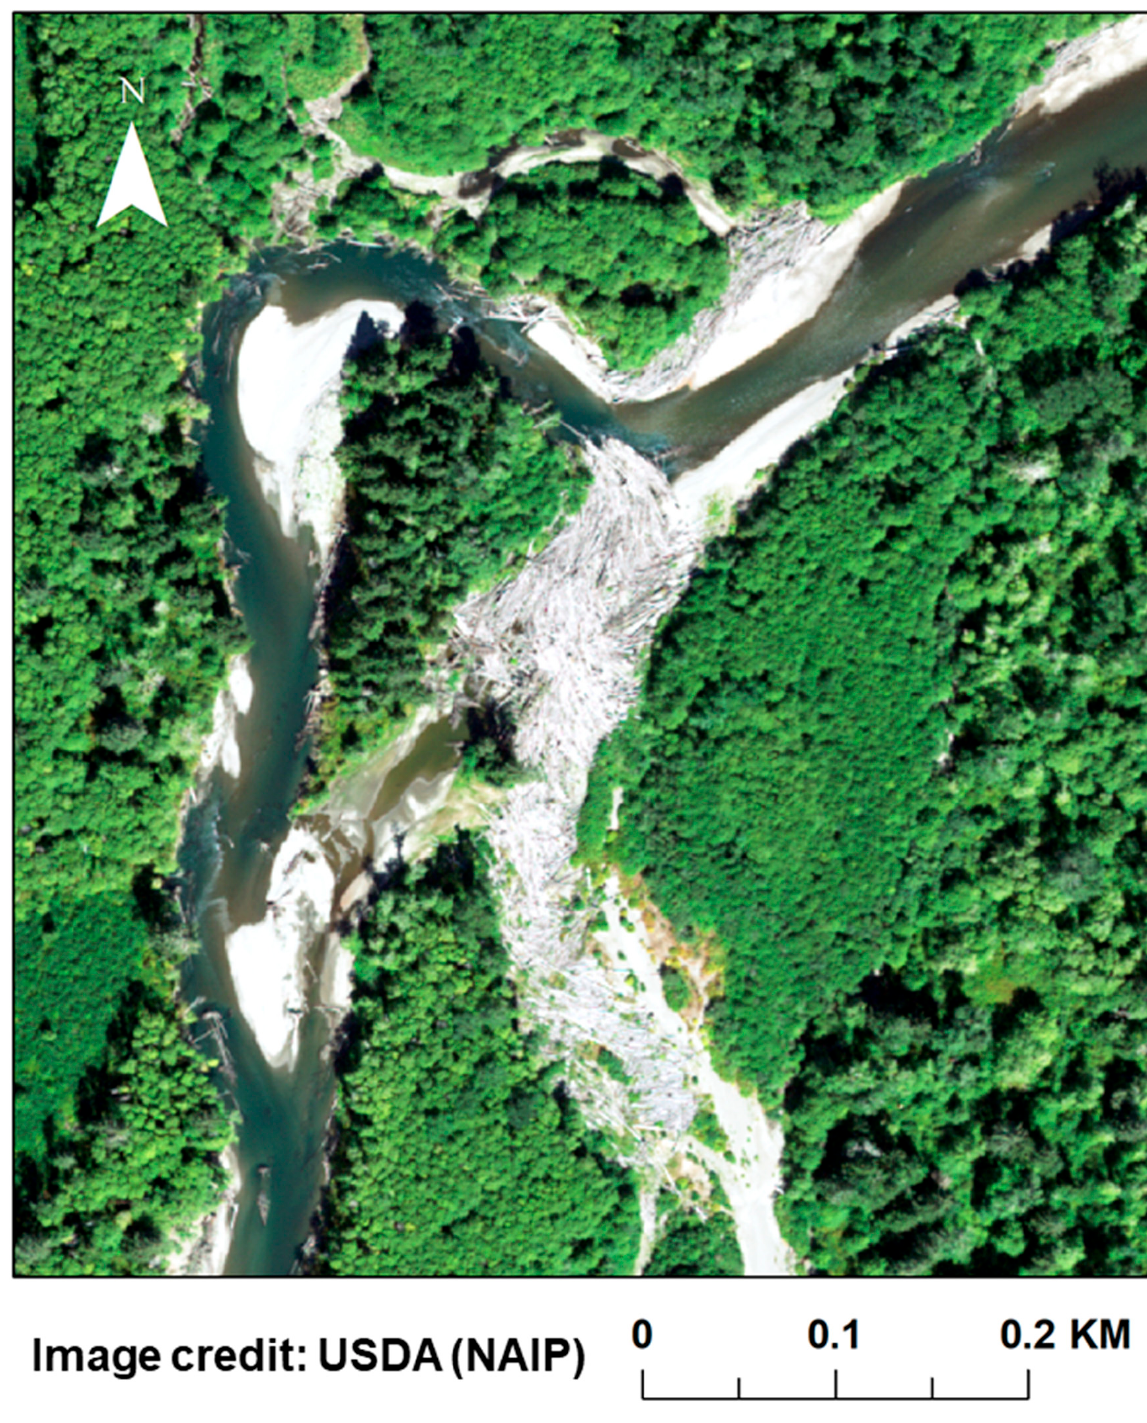
Figure 5. Large wood promotes avulsions and the development of multi-thread channel morphology. Note the logjams regulating inflow into the secondary and abandoned channels. Sediment storage facilitated by large wood appears to contribute to channel infilling. Flow from top to bottom. Image source: USDA The National Agriculture Imagery Program (NAIP).